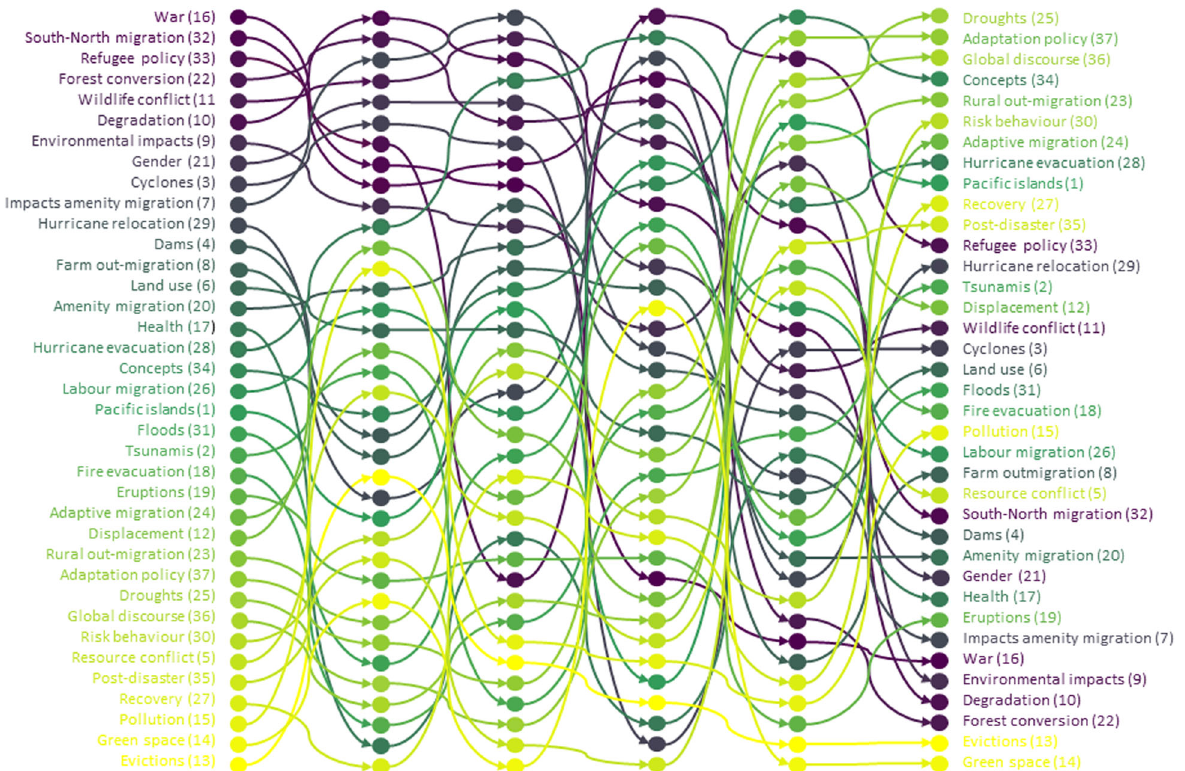
Fig. 4 Topic prevalence ranked over the last 30 years. Articles in each topic are grouped in fi ve-year intervals and ranked from 1 (most prevalent in an interval, top) to 37 (bottom). Numbers in brackets refer to topic